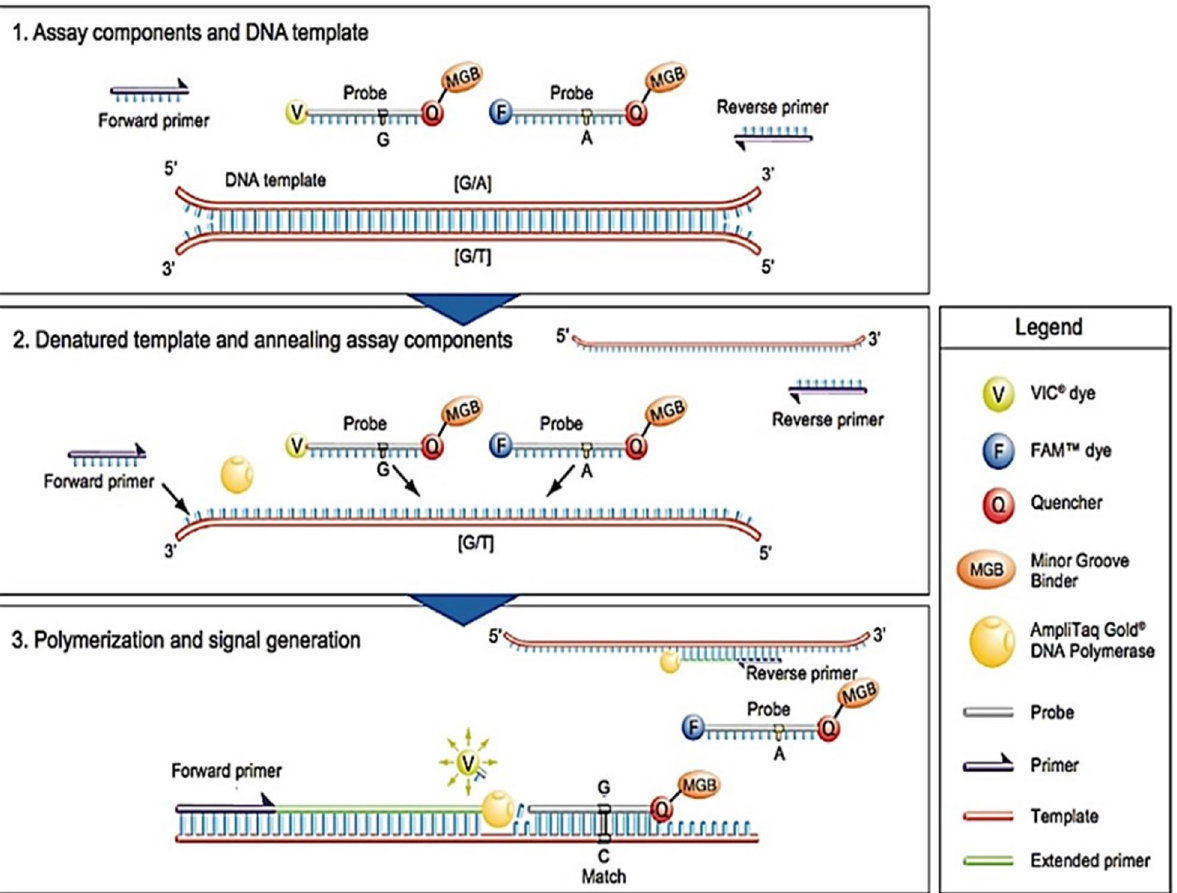
Fig. 1 Mechanism of the TaqMan SNP genotyping assay according to the manufacturing kits (Thermo Fisher Scientific, USA)